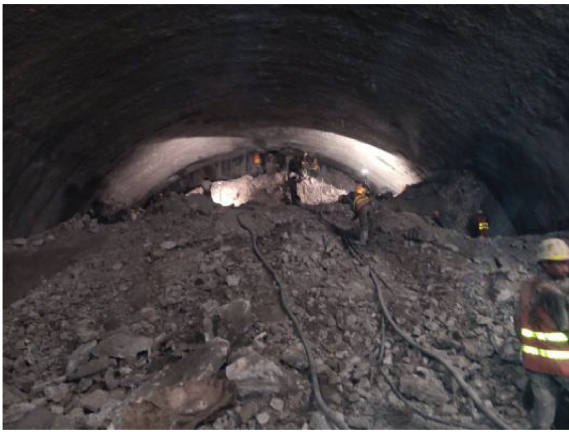
Figure 2: Typical geological conditions.